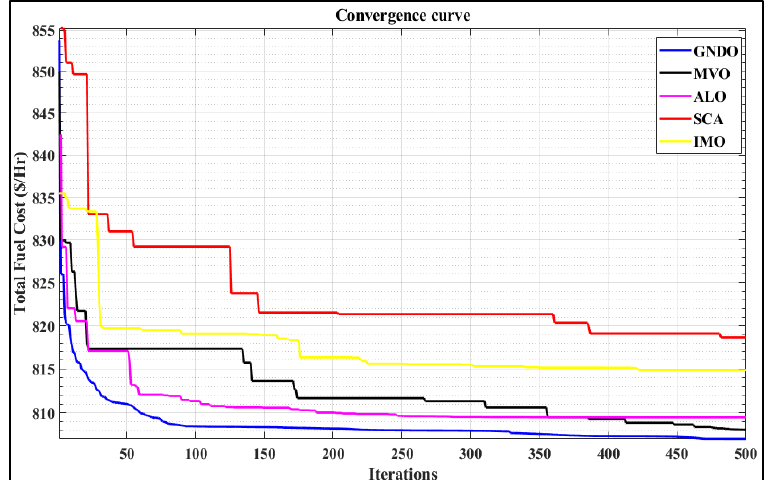
Figure 13. Convergence characteristics of TFC minimization.